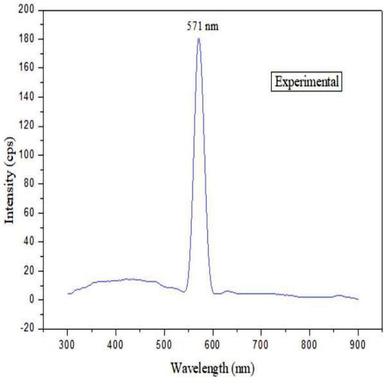
G4C3NBM's luminescence spectrum.